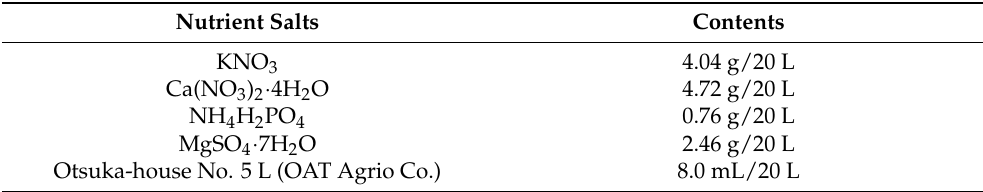
Table 1. Nutrient salts used in the control treatment (Cont.). Nutrient